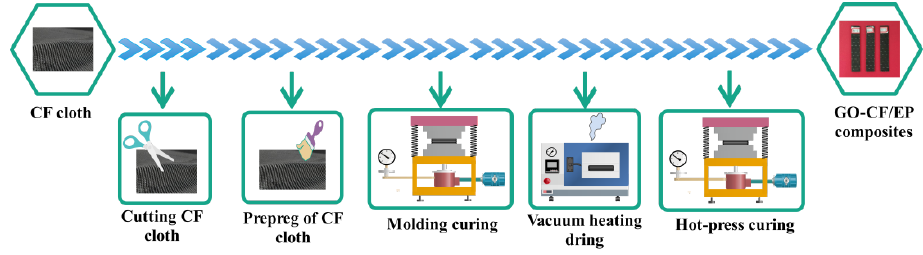
Figure 3. Preparation process of GO-CF/EP composites.